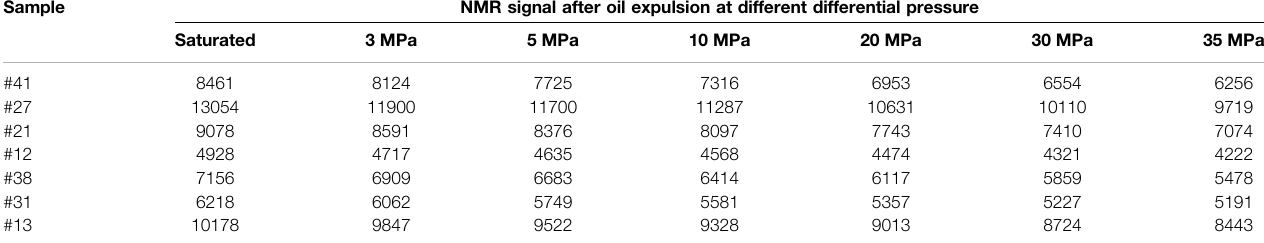
TABLE 2 | NMR data of the experimental samples at the saturated oil state and after the oil expulsion state. Sample NMR signal after oil expulsion at different differential pressure Saturated